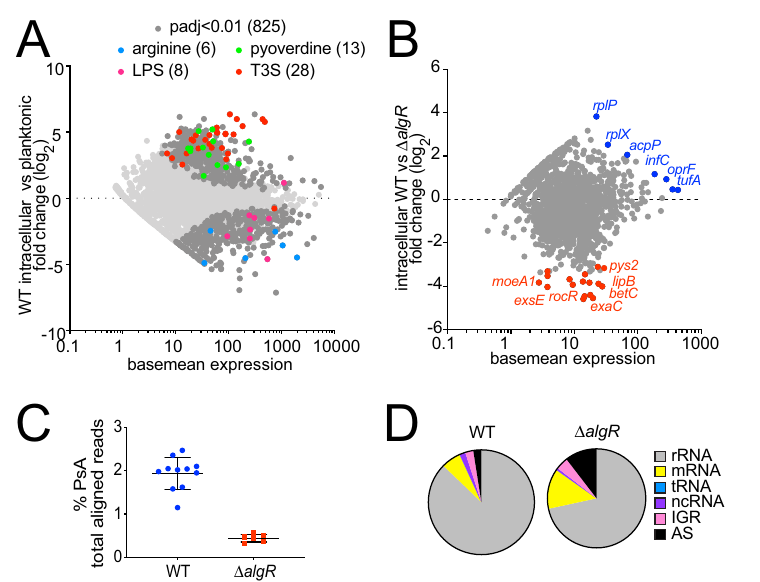
Fig 4. Bacterial adaptation to the host intracellular environment is rapid and is impaired in Δ algR bacteria. Dual RNA-seq libraries of WT- and Δ algR -invaded cells were made from cells sorted 2 hpi and enriched using P . aeruginosa- specific probes using PatH-Cap. (A) Log 2 fold change in gene expression of intracellular versus planktonic WT bacteria. Differentially expressed genes (padj < 0.01 for WT, 825 genes, dark gray) and those differentially expressed in both comparisons encoding genes belonging to pyoverdine biosynthesis (13, green), T3S secretion (28, red), arginine degradation (6, blue), and LPS biosynthesis (8, pink) GO terms are highlighted. (B) Log 2 fold change in gene expression of intracellular P . aeruginosa WT versus Δ algR bacteria. Genes highlighted in blue (7) are expressed at higher levels by intracellular WT bacteria; genes highlighted in red (17) are expressed at higher levels by intracellular Δ algR bacteria (padj < 0.05). Unlabeled points (10) represented uncharacterized genes that encode hypothetical proteins. (C) Percent of reads from dual RNAseq pre-PatH-Cap libraries that align to P . aeruginosa genome. (D) Composition of bacterial fraction of dual RNA-seq pre-PatH-Cap